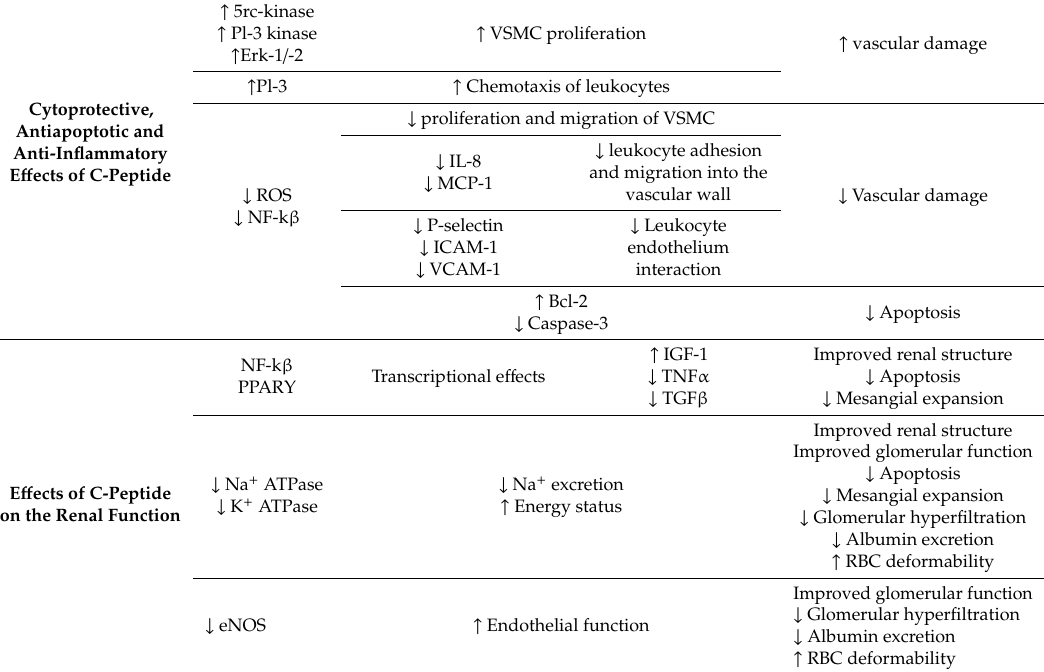
Table 1. E ff ects of C-peptide on cytoprotecting (against cell apoptosis and inflammation), on the renal function and on diabetic neuropathy (adapted from